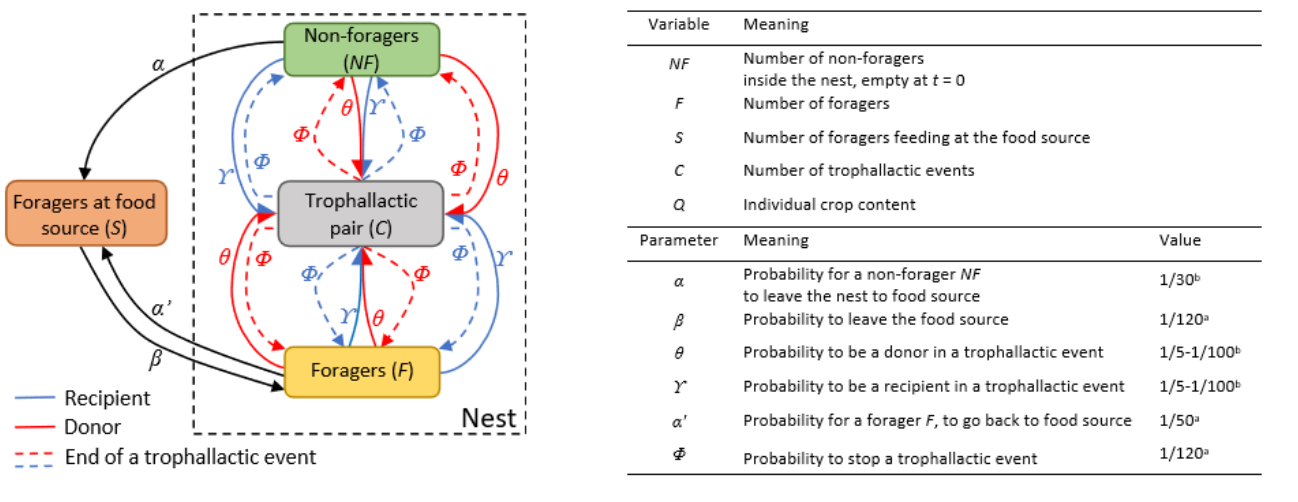
Figure 1. Flow diagram of the model, variables and parameters. The square boxes representing the states of the individuals ( NF , F , S , C ). Black arrows are state transition rates; coloured arrows represent the formation of a trophallactic pair, the red one being the donor and the blue one the receiver. On the right part of the figure, the variables and parameters are defined, and the values of parameters implemented are indicated. a Parameters estimated from the experiments presented in the Material and Methods section or derived from the literature [46,48]. b Parameters estimated by fitting in the experiments.